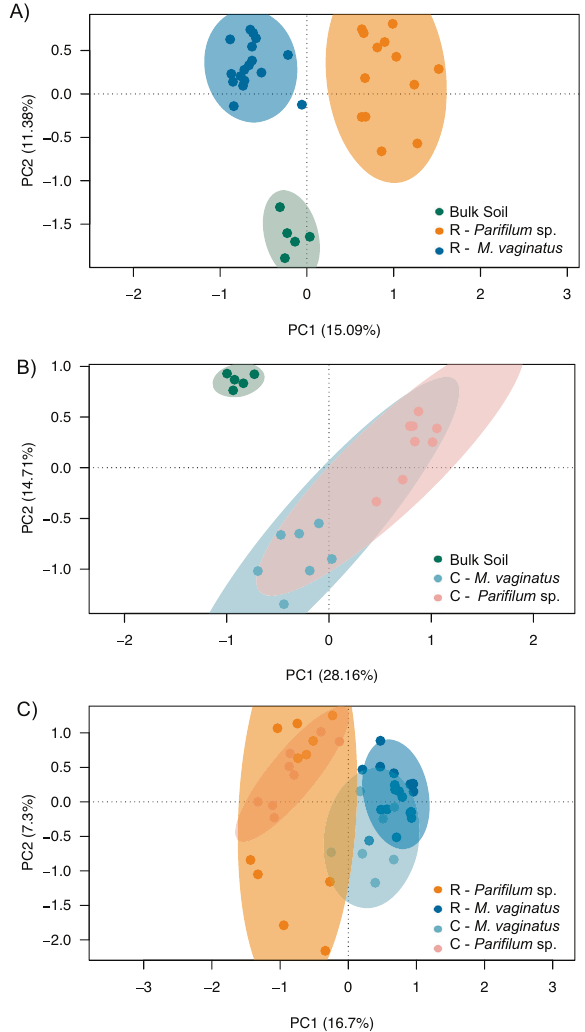
Fig. 4 Divergence in community composition of non- cyanobacterial cyanospheres and bulk soil. Principal component analysis based on Bray-Curtis pairwise distances calculated from Hellinger transformed tables containing sequences and their frequency of occurrence, with 95% con fi dence ellipses drawn for each community. A Comparison of bulk soil ( n = 5), randomly- sampled Pari fi lum sp. (R- Pf ; n = 13) and randomly-sampled M. vaginatus bundles (R- Mv ; n = 17). B Comparison of bulk soil ( n = 5) and M. vaginatus (C- Mv ; n = 7) and Pari fi lum sp. (C- Pf ; n = 8) sampled the same cm-scale patch. C Comparison of cyanospheres from all sampling groups (randomly-sampled Para fi lum sp., randomly- sampled M. vaginatu s, collocated M. vaginatus and collocated Pari fi lum